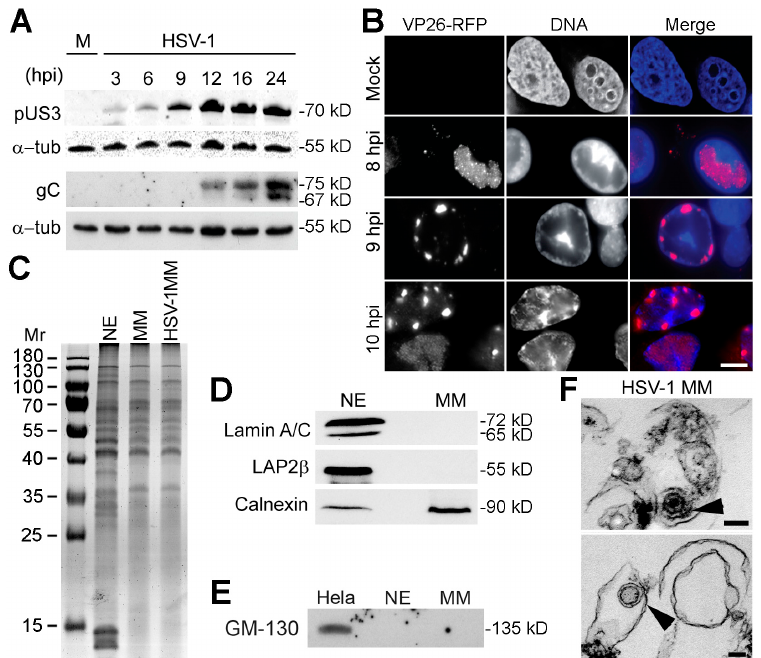
Figure 1. Optimization of conditions to isolate HSV ‐ 1 infected MMs. ( A ) An expression timecourse